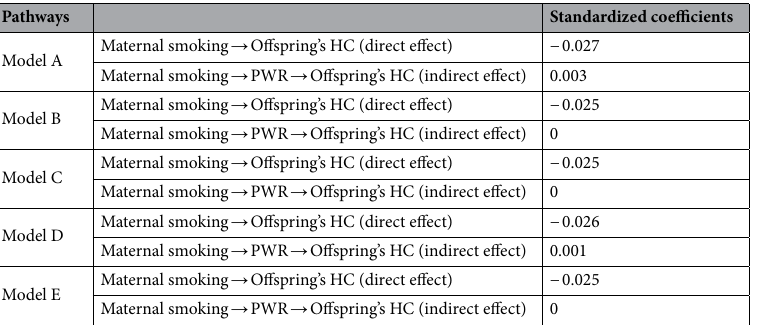
Table 4. Direct and indirect effects and intermediate rate of predictor variables. Each model is assigned for the Fig. 2 panel with same letter (e.g. Model A is assigned for Fig. 2A). HC head circumference, PWR placental weight